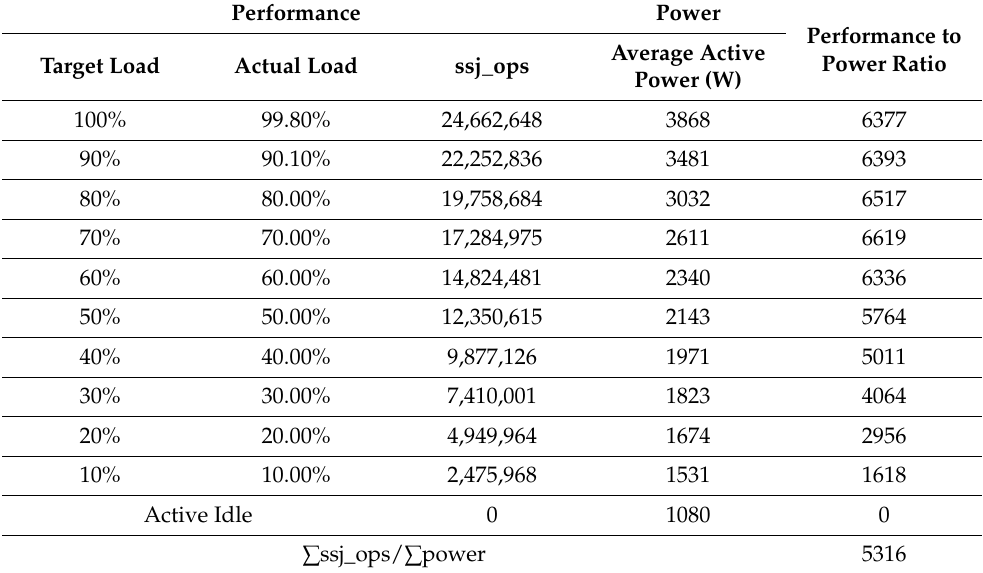
Table 2. An example of SPECpower_ssj2008 testing result in